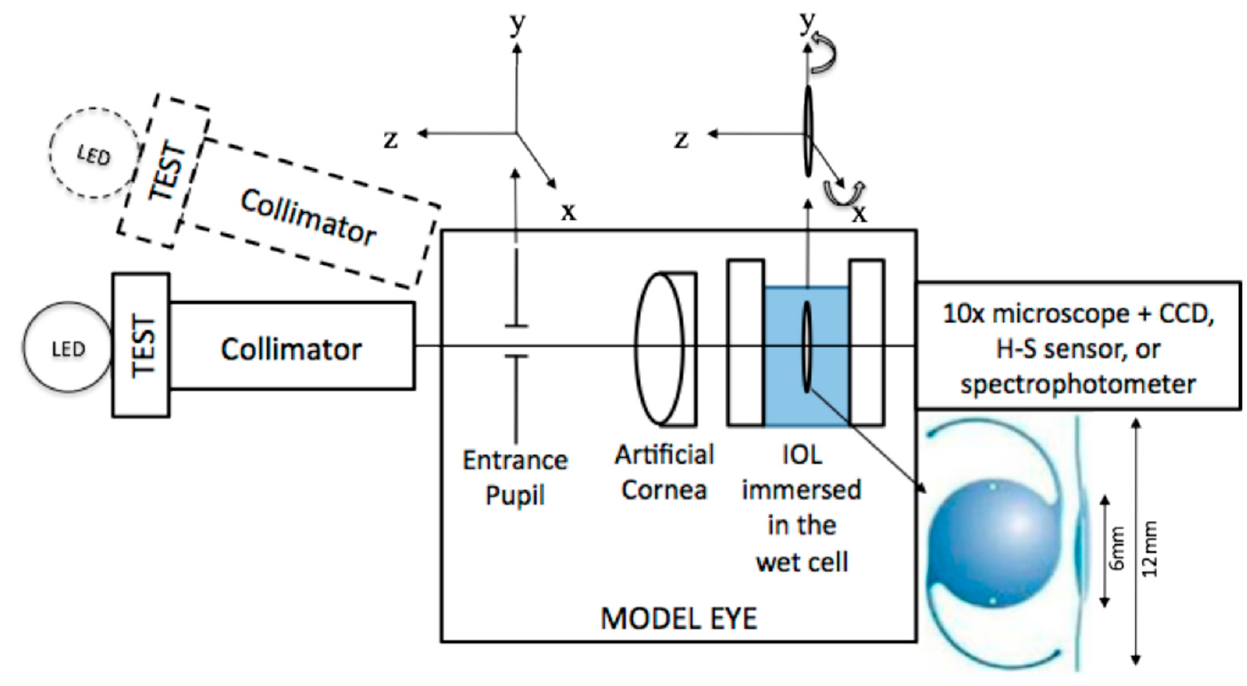
Figure 14. Scheme of an optical layout using an artificial cornea. Reprinted from Ref. [77] under the terms of the Creative Commons Attribution (CC BY) license by IOP Publishing Ltd., Bristol, UK.